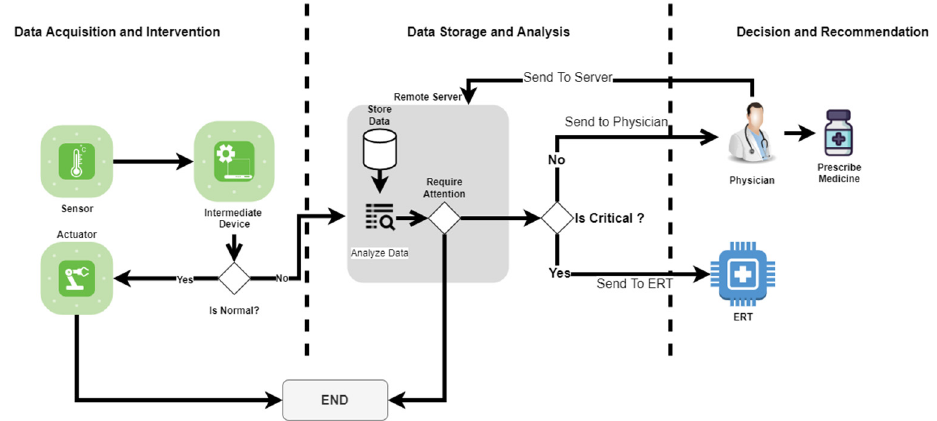
Figure 5. Workflow Diagram of IoHT Implementation.